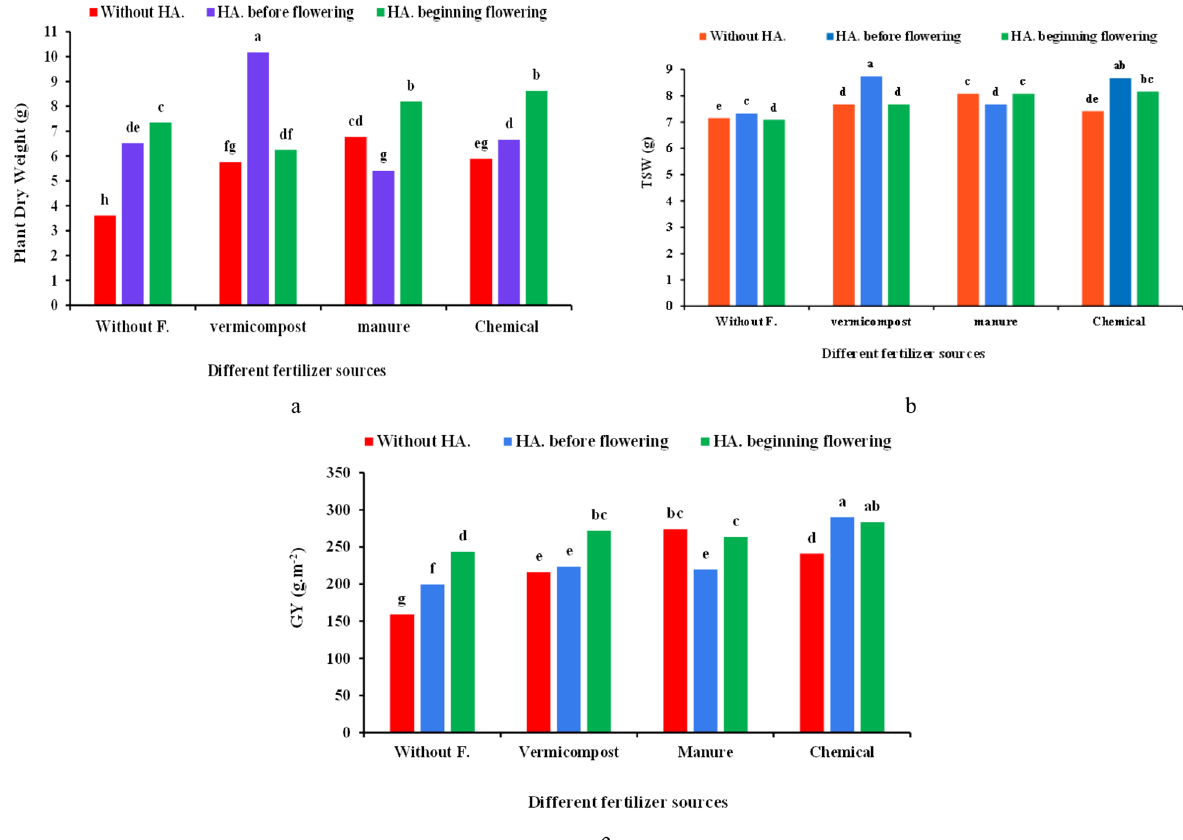
Figure 2. Effect of different fertilizers sources × humic acid (HA) treatments on the plant dry matter ( a ), Thousand-seeds weight (TSW) ( b ), and grain yield (GY) ( c ) of coriander. Different letters indicate significant differences according to LSD test P < 0.05 (average of two